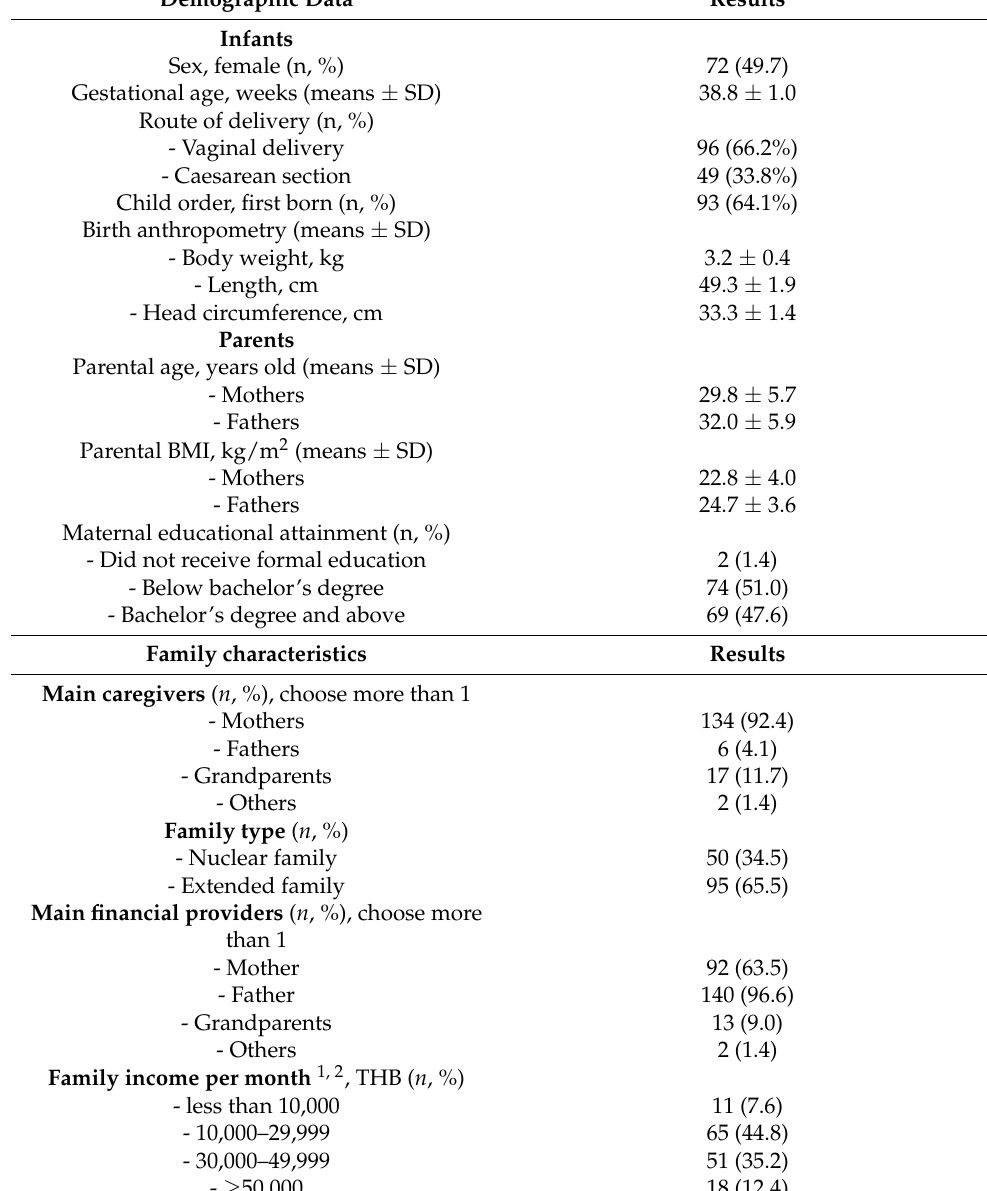
Table 1. Demographic data and family characteristics ( n =